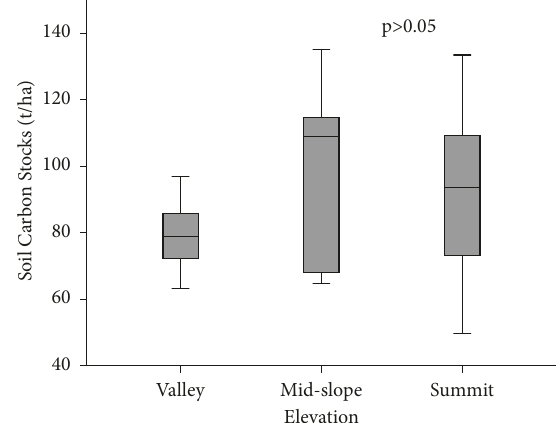
Figure 2: Soil carbon stocks at depth (0–30cm) within the 7-year- old teak plantation at different elevations. The values represent means and their corresponding standard errors.